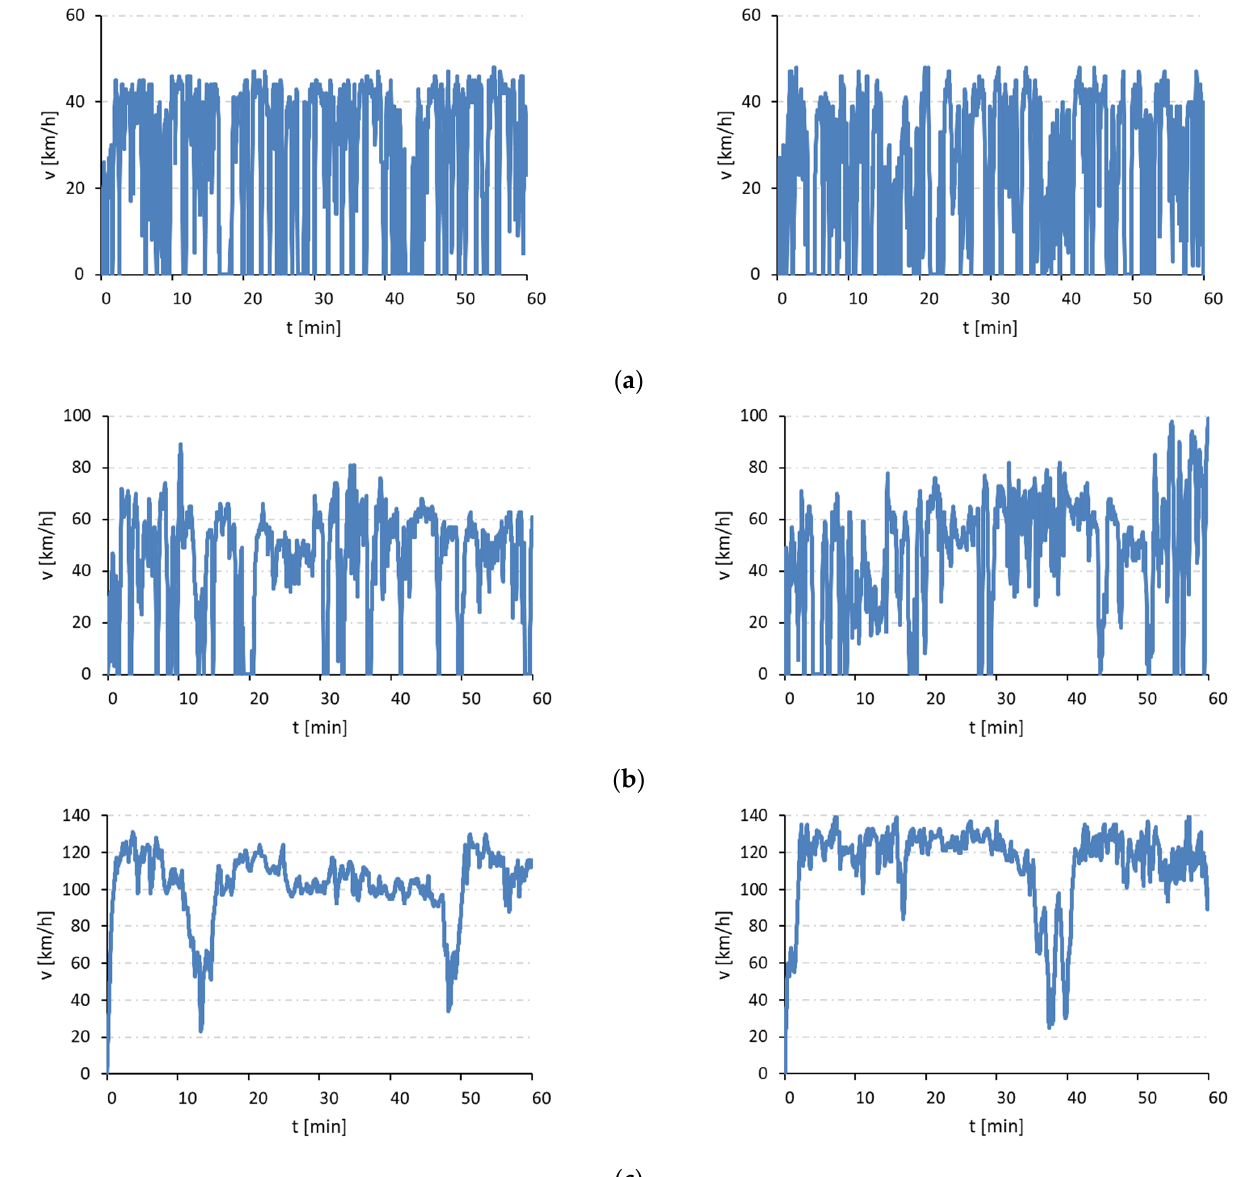
Figure 1. Course of the speed for Vehicle 1 (on the right side), and Vehicle 2 (on the left side), recorded during one hour of driving on: ( a ) city streets, ( b ) rural roads, ( c ) motorways. Table 1. Key parameters of the vehicles used for acquisition of the measured data.